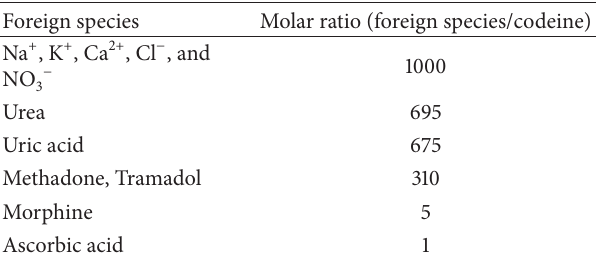
Table 2: Interference study of some species for the determination of 40.0 𝜇 M of codeine at